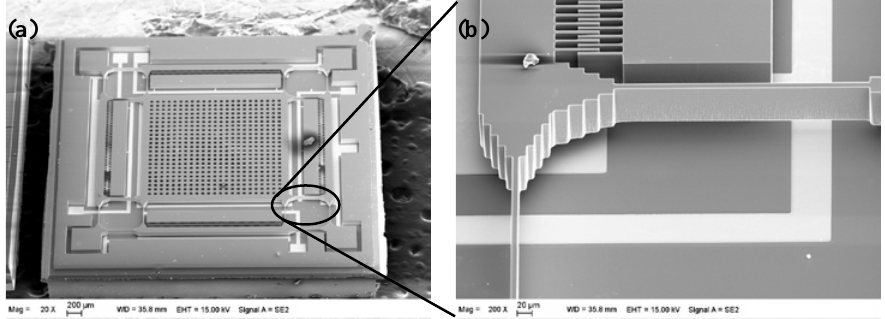
Figure 10. SEM of micro gyroscope fabricated by the SOG process. ( a ) Top view of the gyroscope; ( b ) Side view of the gyroscope.